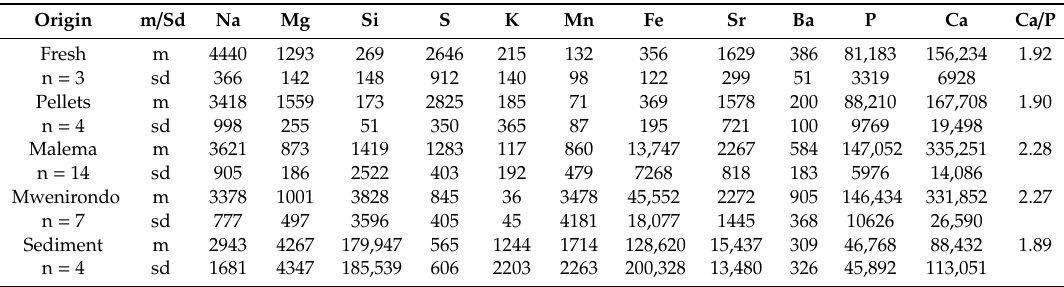
Table 1. Elemental composition of bones and sediment (in ppm) obtained from EDS analyses; m = mean; sd: standard deviation; n: number of analysed bones. A minimum of 10 punctual analyses were completed for every bone, ca a total of 320 EDS analyses.